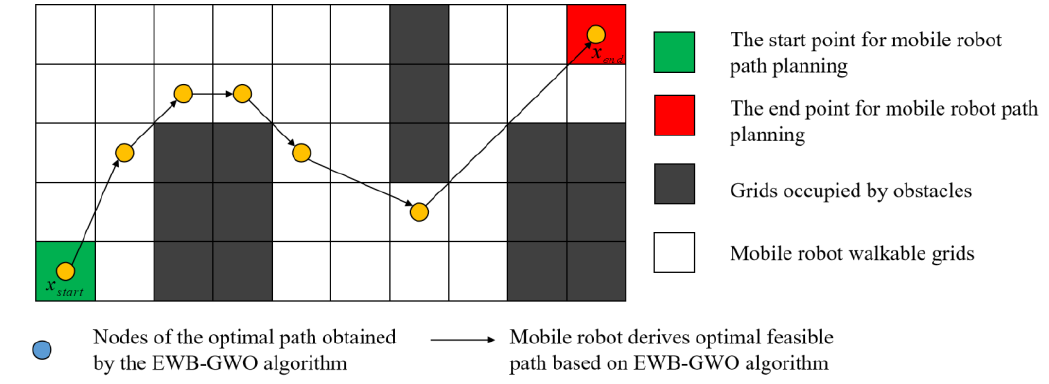
Figure 9. Complete path example for unmanned delivery robot path planning.